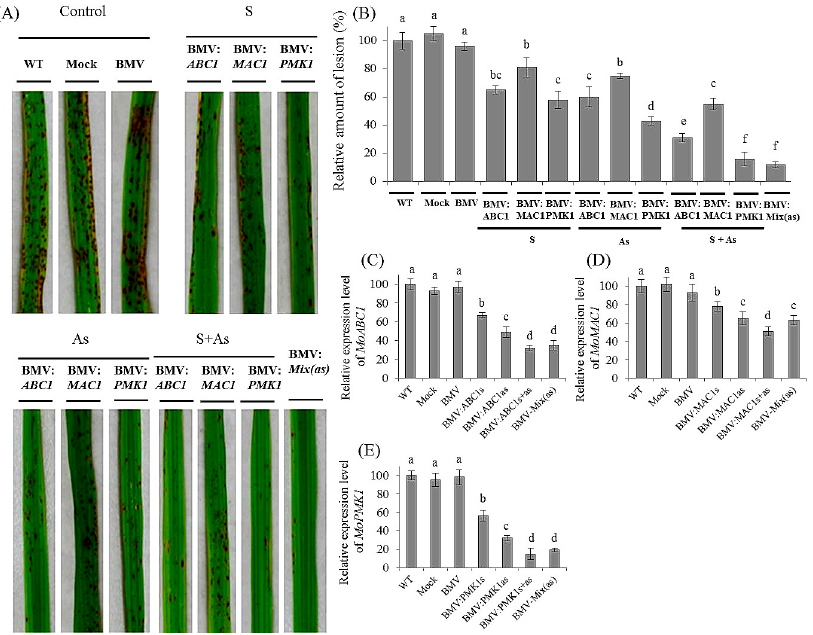
Figure 4. Effect of BMV-derived HIGS of targeted MoABC1 , MoMAC1 and MoPMK1 on disease development in rice. Leaf 2 of 2-week-old rice CO-39 plants were infected with BMV harboring derivatives of recombinant RNA3 vector expressing MoABC1 , MoMAC1 and MoPMK1 gene fragments, in sense (S), antisense (As) or as a mixture of sense plus antisense form (S + As). In addition, some plants were also inoculated with a mixture of BMV carrying derivatives of recombinant RNA3 vector expressing the targeted gene segments in antisense. WT, Mock and BMV (without inserting) plants were selected as the control groups. After 10 days of BMV infection, rice plants were treated with M. oryzae . ( A ) Rice blast disease phenotype in the control and silenced rice plants. Plants were treated with BMV vectors harboring candidate M. oryzae gene fragments. After 10 days of fungal infection, the 6th leaves had photographs taken. ( B ) Quantification of lesion density on rice plants treated with BMV vectors carrying the targeted gene fragments and controls. After 10 days of M. oryzae infection, lesions in leaves from 15 independent plants were counted. Furthermore, qRT-PCR analysis of the expression of MoABC1 ( C ) MoMAC1 ( D ) and MoPMK1 ( E ) in rice leaves inoculated with BMV variants, including S, sense; As, antisense; S + As, sense plus antisense, and BMV-Mix(as). Each experiment was performed with three biological repeats. Values represented mean ± SD in three independent experiments, and 15 individual leaves from different plants were collected for each experiment. Different letter indicated a significant difference at p <